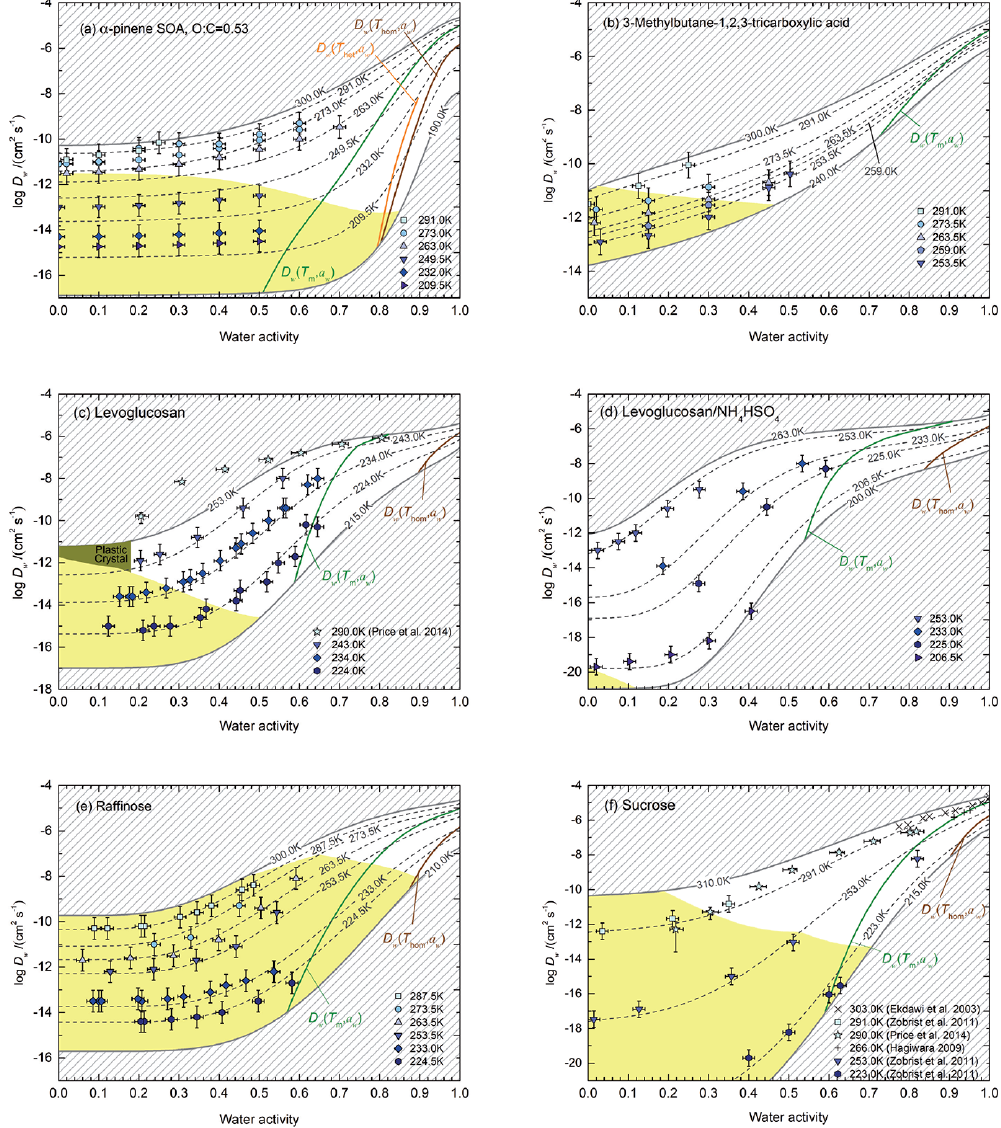
Figure 2. Water diffusion coefficients, D w (T,a w ) , derived from kinetic response experiments shown together with the available data from the literature (Ekdawi-Sever et al., 2003; Hagiwara et al., 2009; Price et al., 2014). The color and shape of the data points indicate the temperature at which the data were obtained. The dashed lines are the temperature and composition dependent fits through all data points using the modified Vignes equation (see Appendix A). The fits were also used to calculate water diffusivity along the ice melting temper- ature, D w (T m ,a w ) , green lines, where T m is calculated according to Murphy and Koop (2005) and along the homogeneous ice freezing temperature, D w (T hom ,a w ) , brown lines, where T hom is calculated according to Koop et al. (2000) for a droplet of 100nm radius and a homogeneous nucleation rate of ω = 1min − 1 . The orange line in panel (a) represents water diffusivity at conditions required for het- erogeneous ice nucleation in SOA particles, D w (T het ,a w ) , where T het is calculated according to Berkemeier et al. (2014). The yellow areas mark the regions where the mixtures are in the glassy state according to glass transition temperatures given in Appendix A. (a) α - pinene SOA O:C = 0.53, H:C = 1.50, (b) 3-methylbutane-1,2,3-tricarboxylic acid (3-MBTCA), O:C = 0.75, H:C = 1.5 (c) levoglucosan, O:C = 0.83, H:C = 1.67, (d) levoglucosan/NH 4 HSO 4 mixture with a dry molar ratio of 1 : 1, (e) raffinose, O:C = 0.89, H:C = 1.78, (f) su- crose, O:C = 0.92, H:C = 1.83. Note that the range of temperatures for which measurements have been performed and the scales for the water diffusion coefficients vary between the different